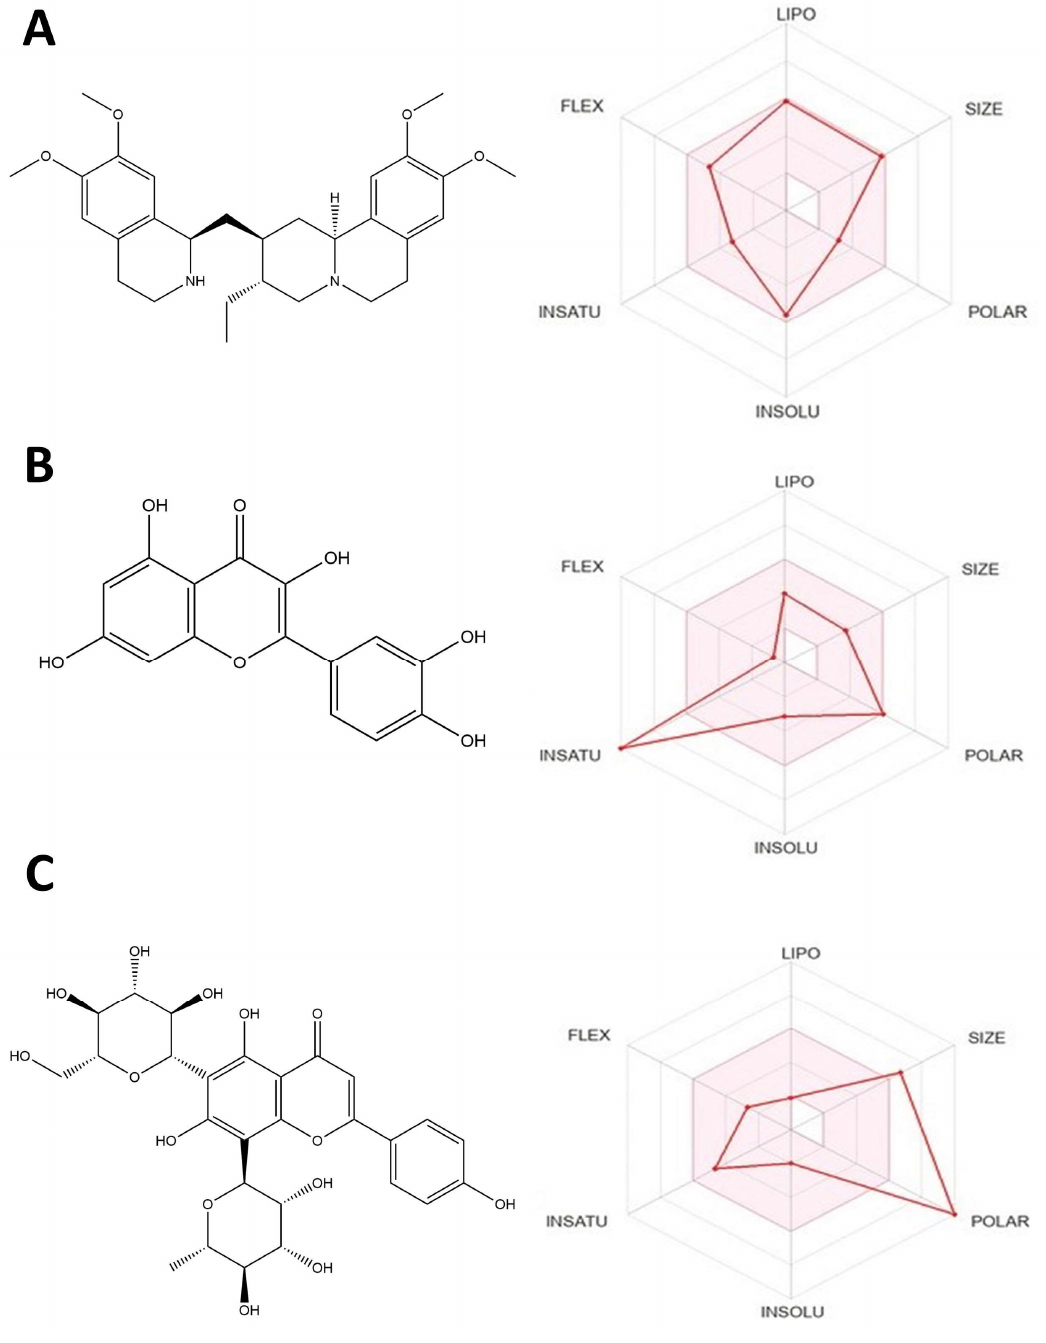
Figure 2. ( A ) ADMET bars for emetine (compound 1 ). ( B ) ADMET bars for quercetin (compound 2 ). ( C ) ADMET bars for violanthin (compound 3 ).